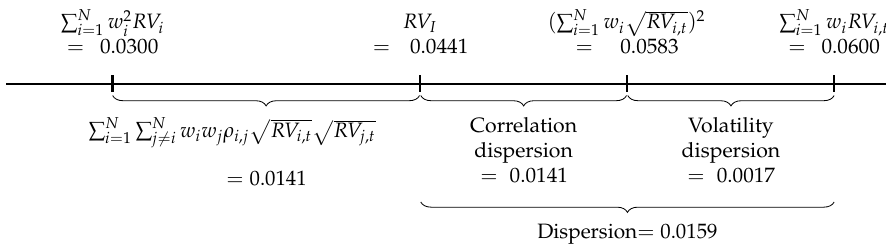
Figure 1. Visualisation of dispersion trade performance drivers. Figure 1. Visualization of dispersion trade performance drivers. Source: authors’